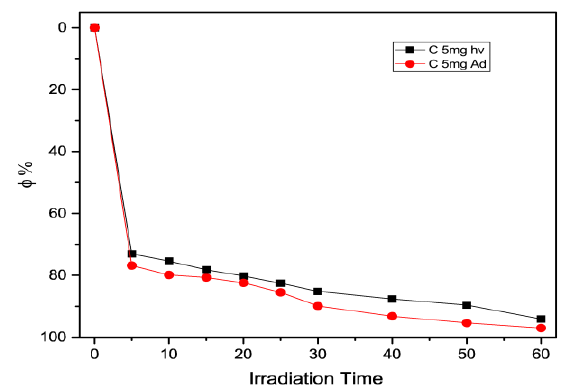
Fig. 8 Time course of Rh-B adsorption on Carbon NPs for both adsorption and photocatalytic